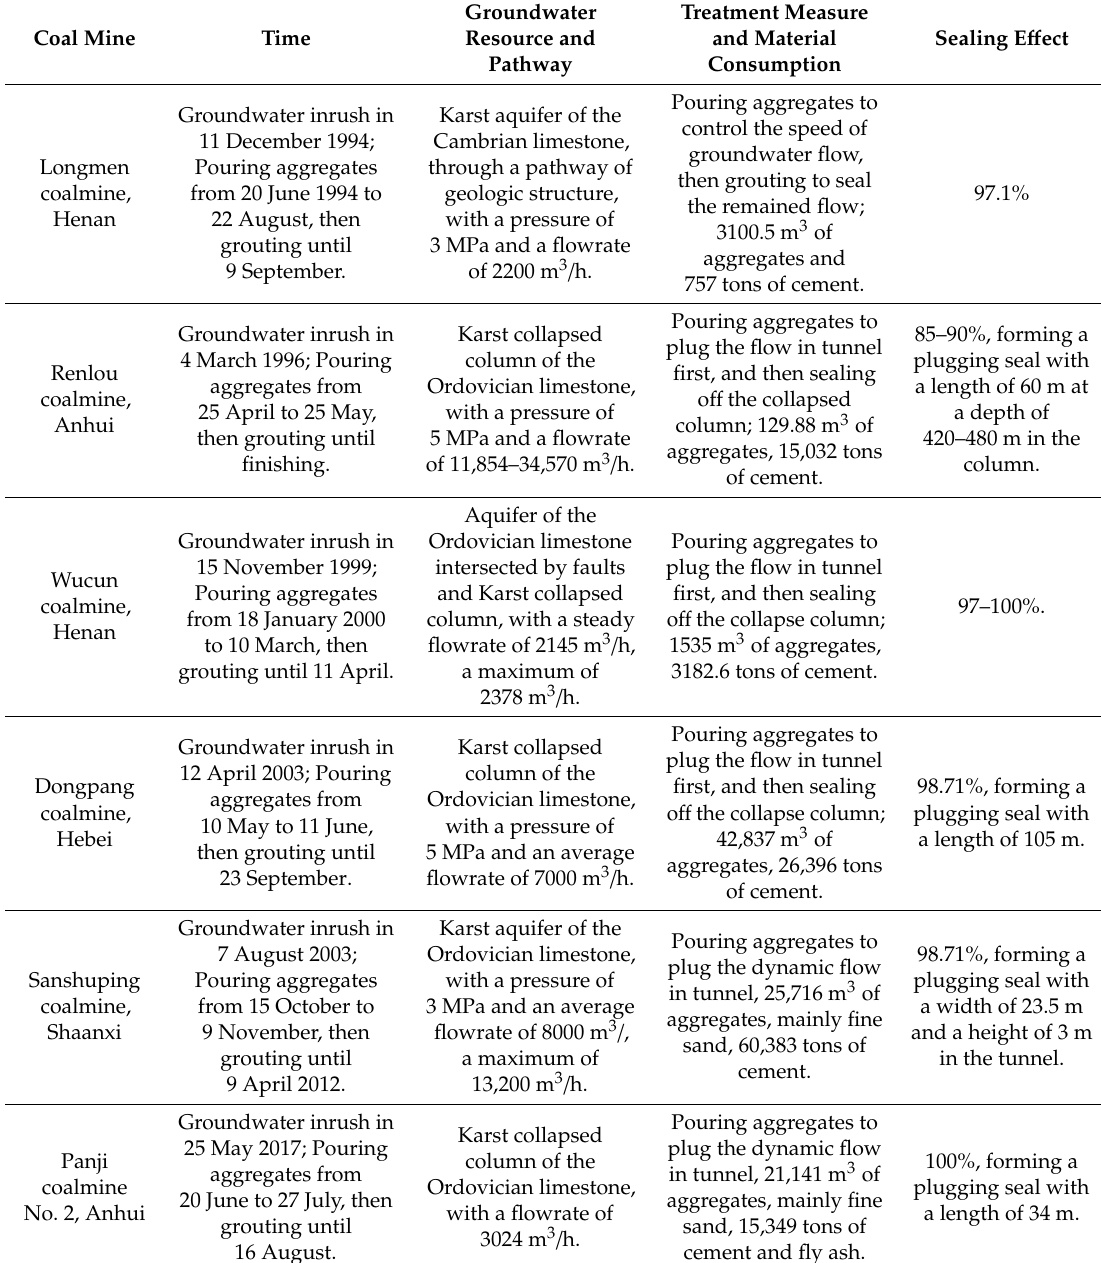
Table 1. Some case histories of plugging groundwater inrushes in tunnels by pouring aggregate in Chinese